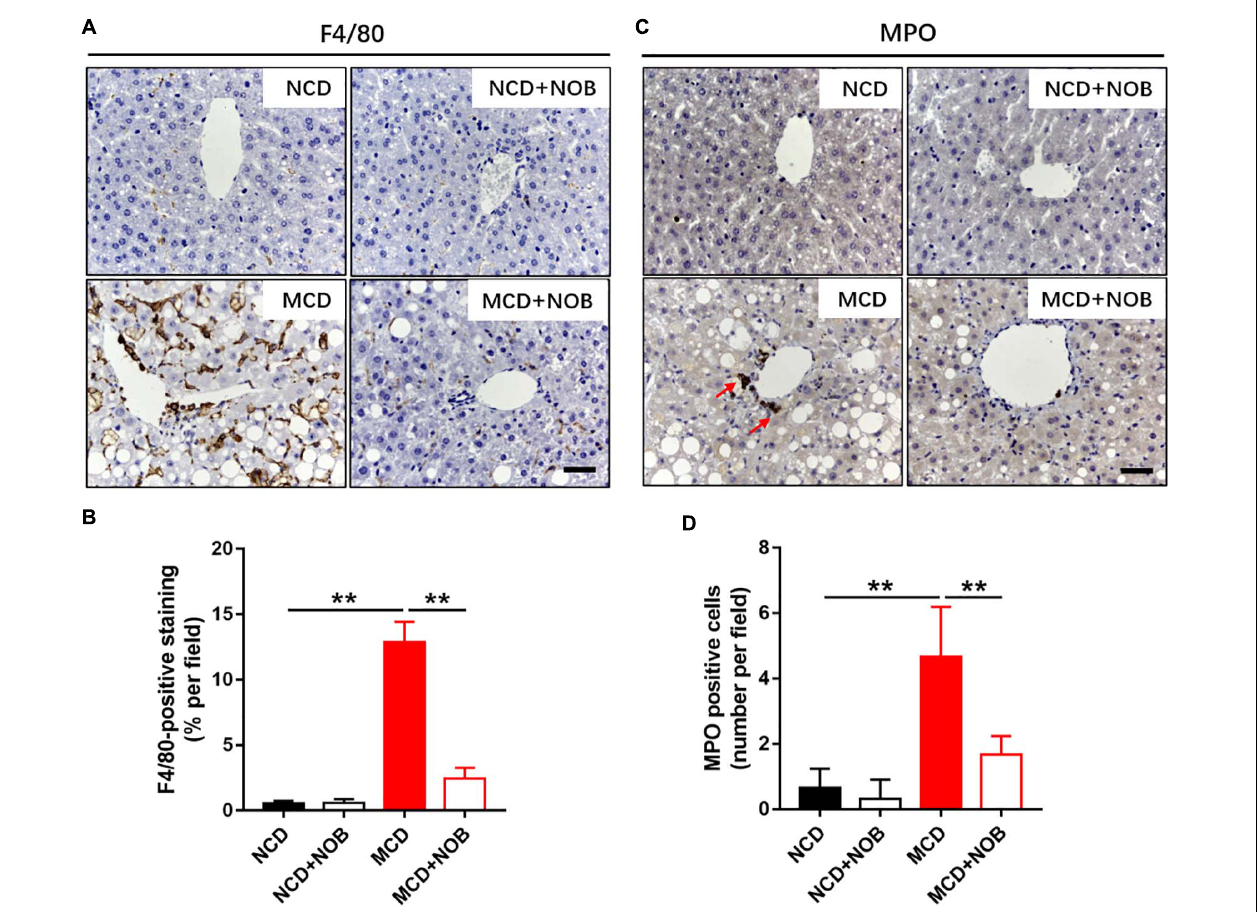
FIGURE 3 | The effect of NOB on the infiltration of macrophages and neutrophils in MCD fed mice. (A) The representative images of F4/80 immunohistochemical staining in liver from each group. Scale bar = 300 µ m. (B) Quantification and statistical analysis of F4/80-stained areas was shown. Data were expressed as the mean ± SD ( n = 8). (C) The representative images of myeloperoxidase (MPO) immunohistochemical staining in liver from each group. Scale bar = 300 µ m. Red arrow points to MPO-positive cells. (D) Quantification and statistical analysis of MPO-positive cells in liver from each group. Data were expressed as the mean ± SD ( n = 8). ** P <